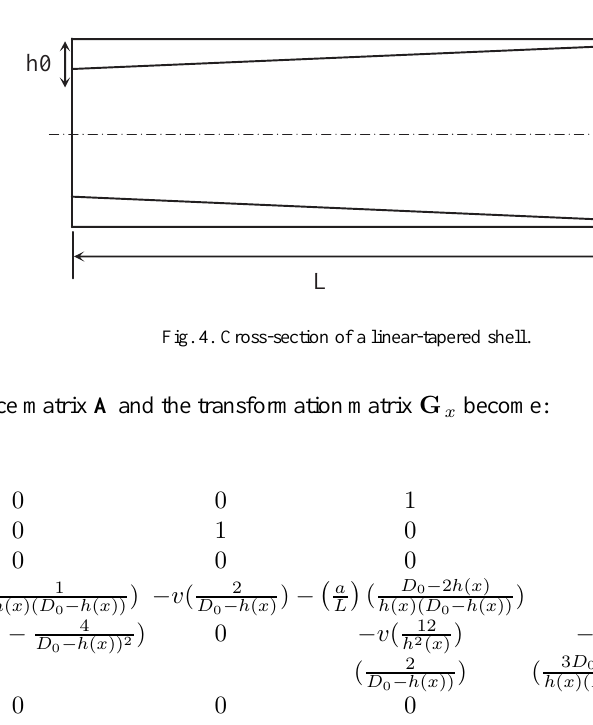
Fig. 3. Propagation constants of uniform (dash) and exponential-tapered (solid) shell: (a) longitudinal direction, (b) radial direction.